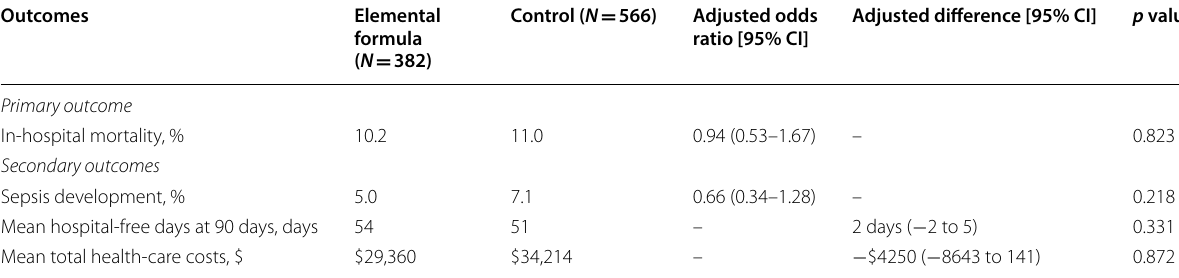
Table 2 Results of multivariate mixed-effects regression analysis